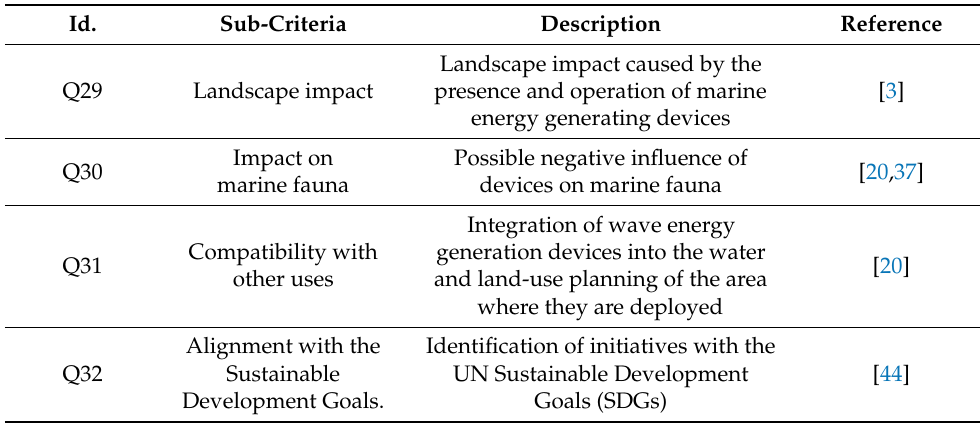
Table A8. Block 7: Influence of environmental factors. Q29 to Q32.